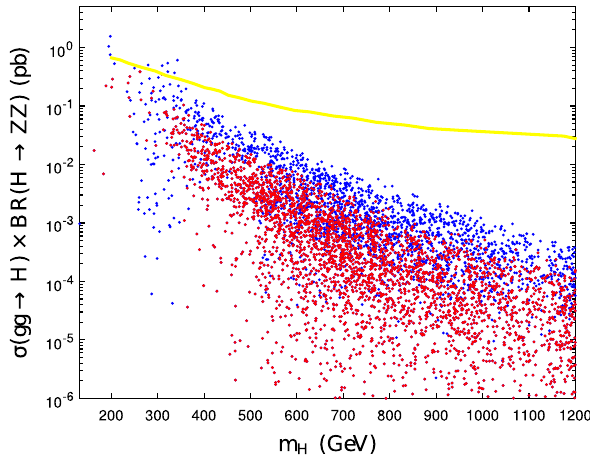
Fig. 4 Cross section of the process pp → gg → H → Z 0 Z 0 at 13TeV collision energy, as a function of the mass of the heavy CP - even scalar H . All the points displayed obey the constraints for our model described in Sect. 4.1. For the blue points, the 125GeV scalar h has all its production rates within 20% of their SM-expected values; for the red points those production rates are all within 10% of their SM values. The yellow line is the 2 σ upper bound given in Ref.